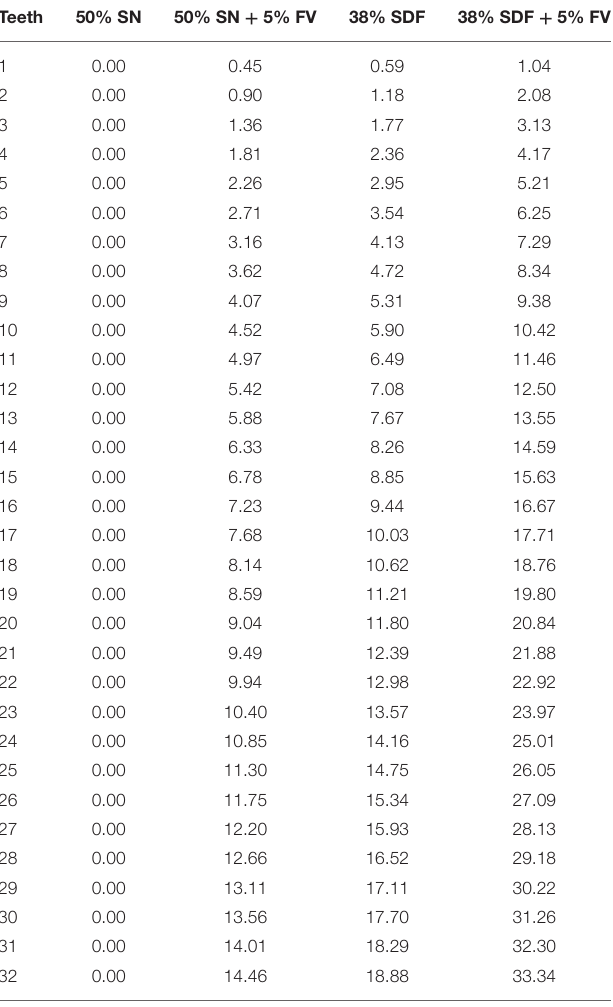
TABLE 2 | Fluoride content (mg) based on number of teeth treated and protocol used (SN or SDF, both with and without FV). Teeth